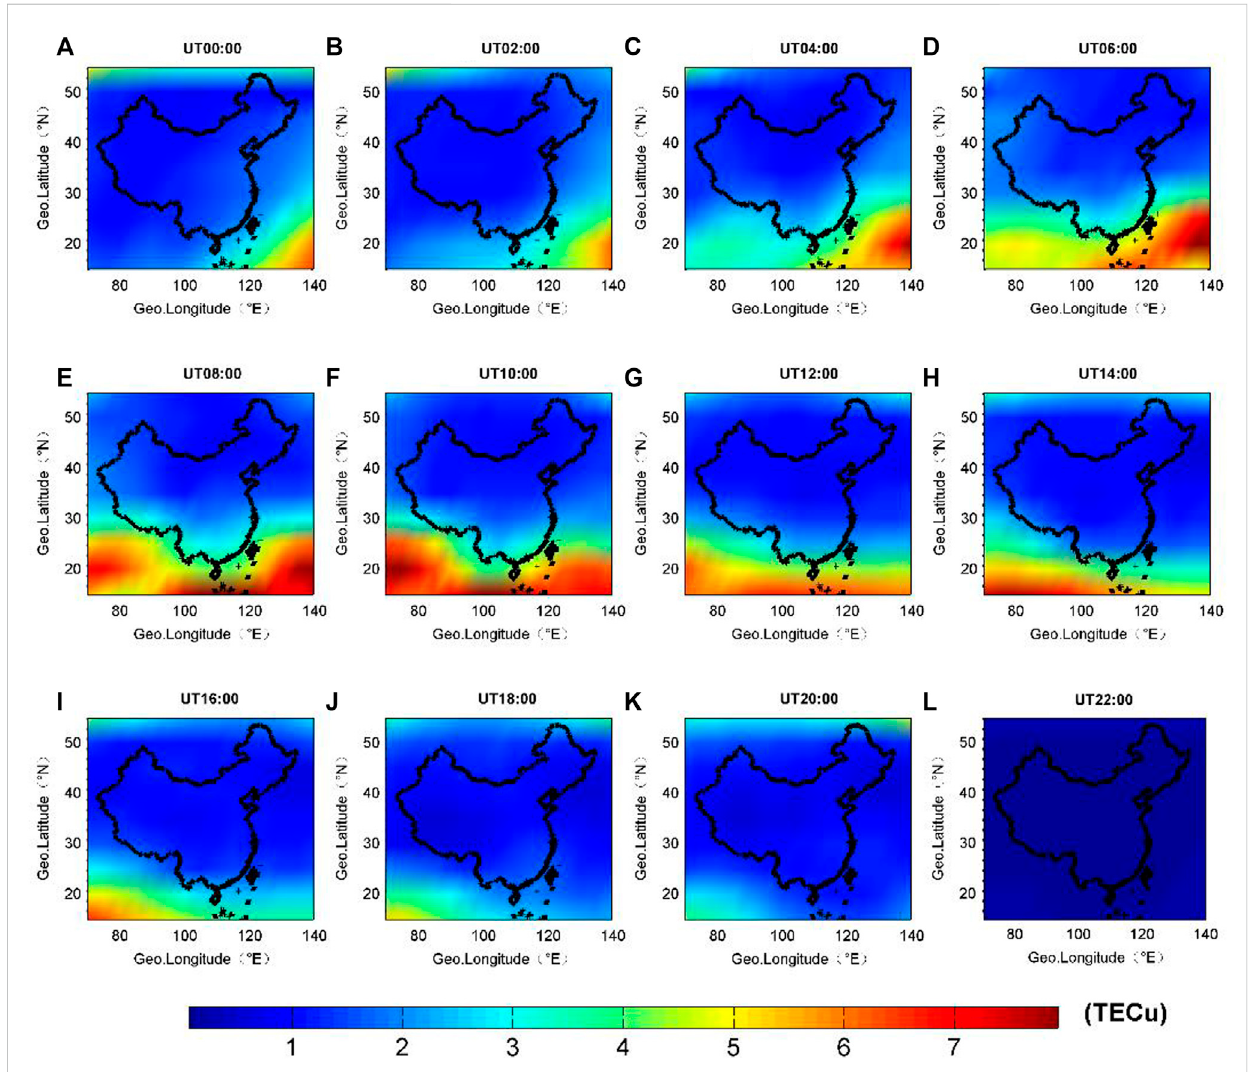
FIGURE 6 The spatial distribution of average STD of IGS GIM compared with RIM, the x -axis and y -axis denote geographic longitude and geographic latitude, respectively. The color scale indicates the magnitude of TEC in TECu.